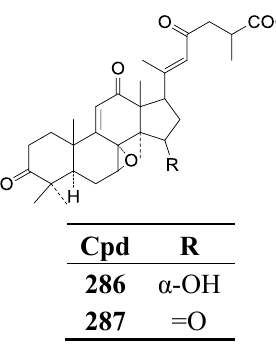
Figure 34. Structures of compounds 286 – 287 .